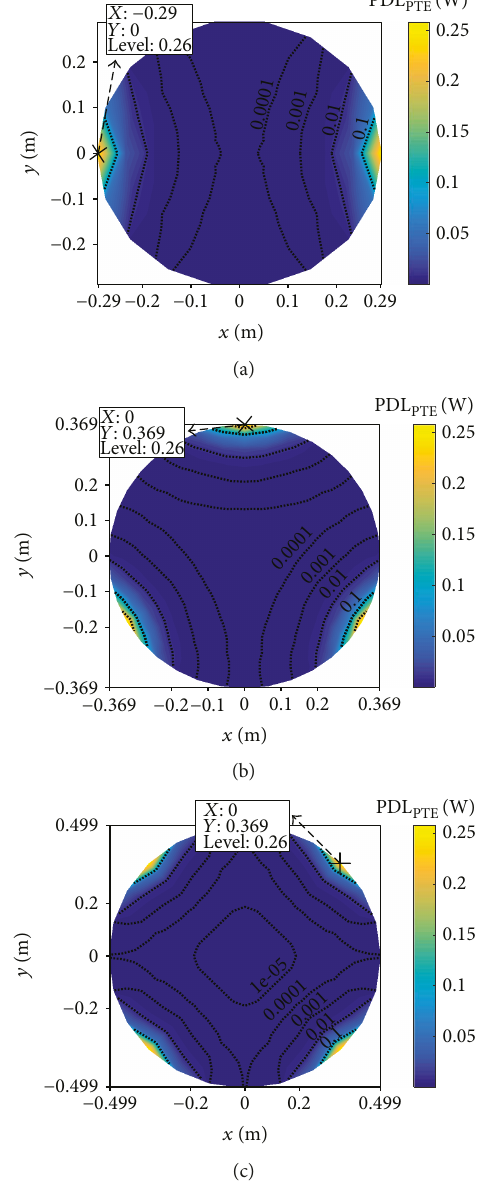
Figure 7: The voltage values of TX 1 for calculating PDL under Figure 8: The values of PDL under conditions of maximizing PTE: conditions of maximizing PTE: (a) two-, (b) three-, and (c) four- (a) two-, (b) three-, and (c) four-TX TX systems.